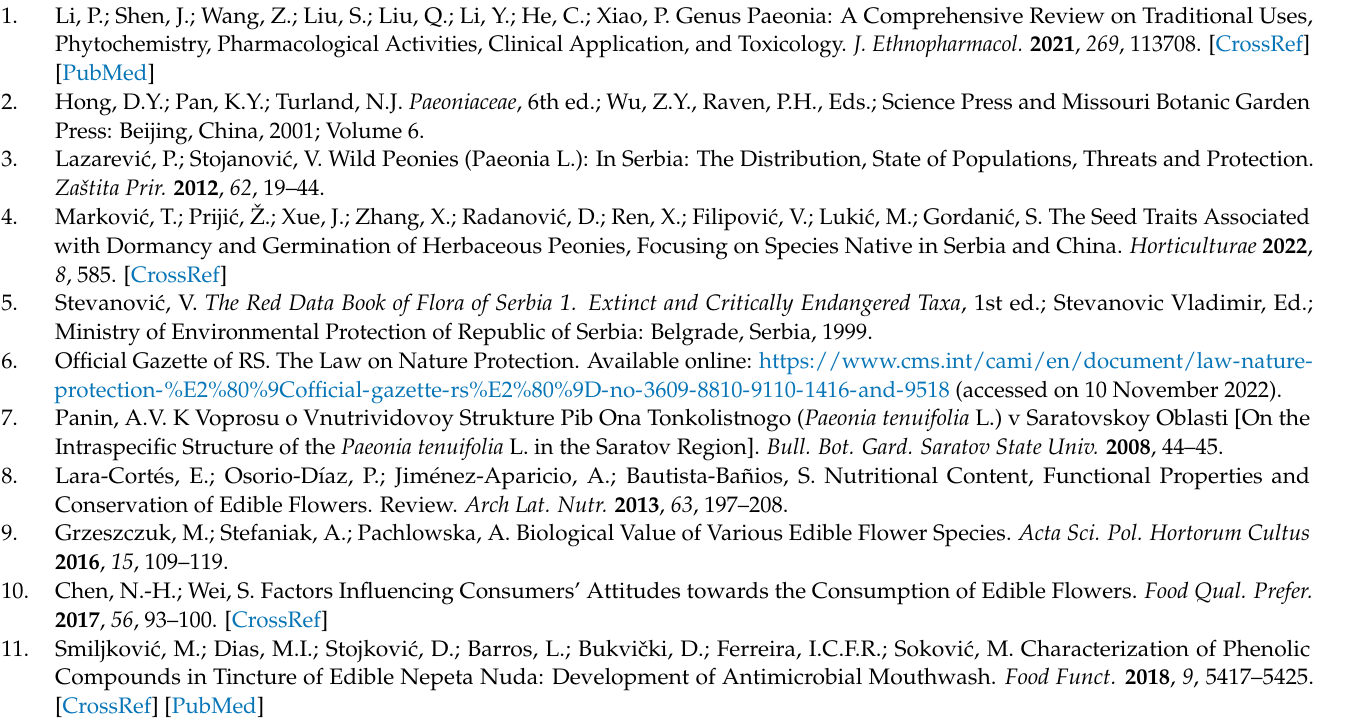
Figure S1: Trolox calibration curve for DPPH • radical scavenging activity, Figure S2: Energy input (blue line—power [W]), pressure (green line—in bars) and temperature (yellow line—temp IR [ ◦